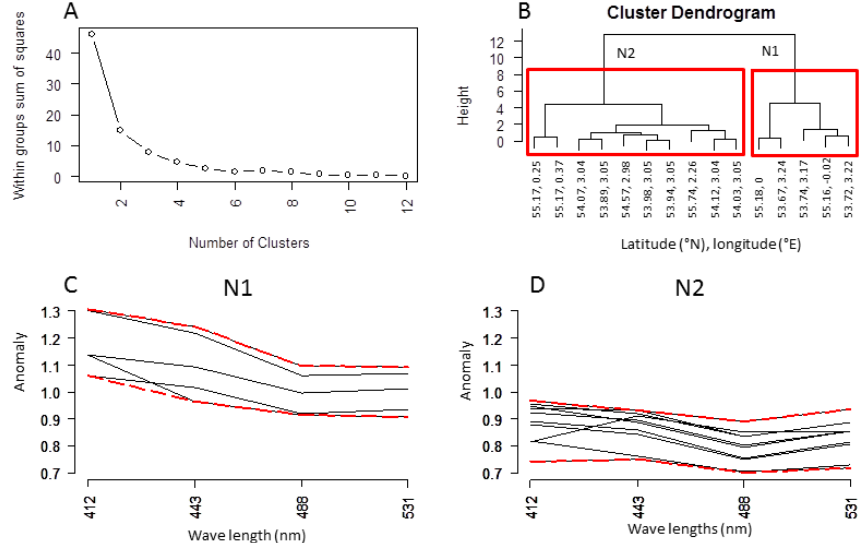
Figure 9. (a) Within sum of squares for the optimal number of k nodes selected corresponding to PHYSAT anomalies. (b) Cluster dendrogram defining the two main nodes grouping similar PHYSAT anomalies matchups (N1 and N2). (c, d) Corresponding RA spectra for N1 and N2. Red dashed lines correspond to the minima and maxima values of the spectra as described in Table 3.